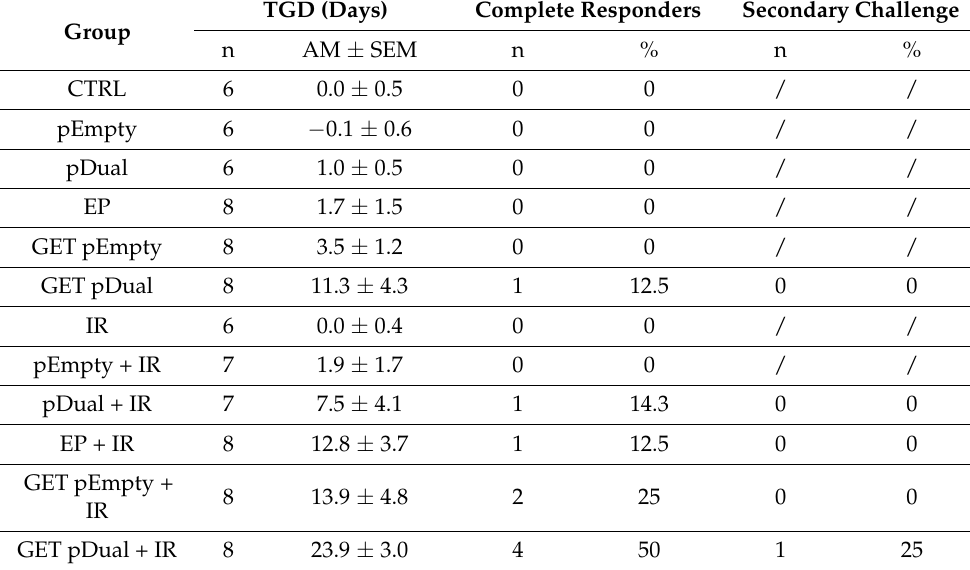
Table 1. Tumor growth delay and complete responses in different experimental groups. TGD (Days) Complete Group